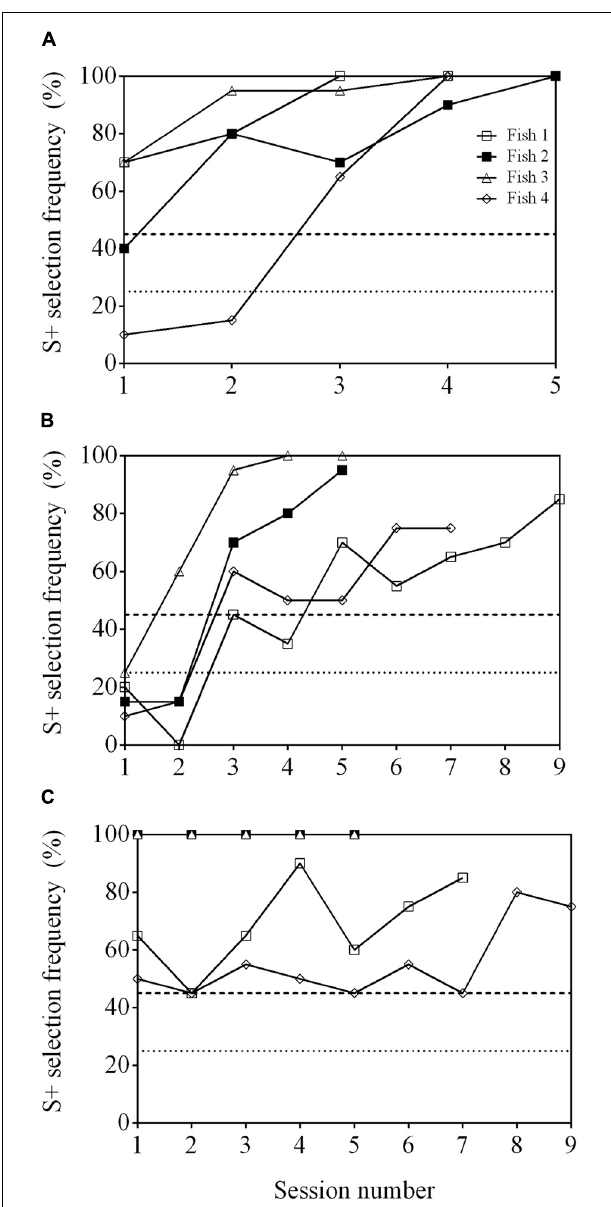
FIGURE 6 | Learning curve of four archerfish conditioned to complete a 4-AFC task. Four stimuli were presented where three stimuli were identical and were unrewarded (S − ) while a single unique stimulus was rewarded (S + ). In A , S + is a cross and S − is a square.The stimuli were then replaced by a star (S + ) and a triangle (S − ; B ). Stimuli were changed for a third time to an arrow (S + ) and a crescent (S − ; C ).The dashed line at 45% in all figures indicates a statistically significant selection frequency of S + and the dashed line at 25% indicates chance. See Table 1 for example stimuli.